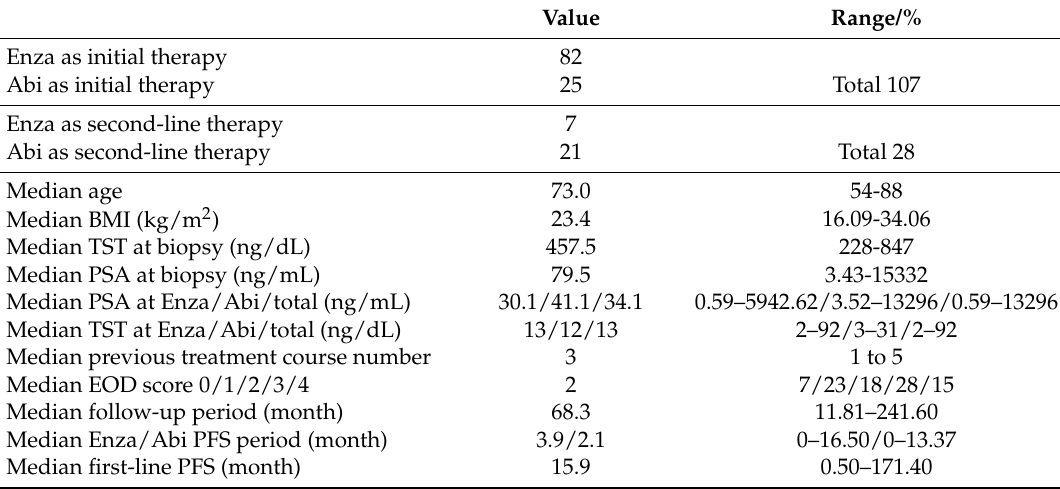
Table 1. Patient’s